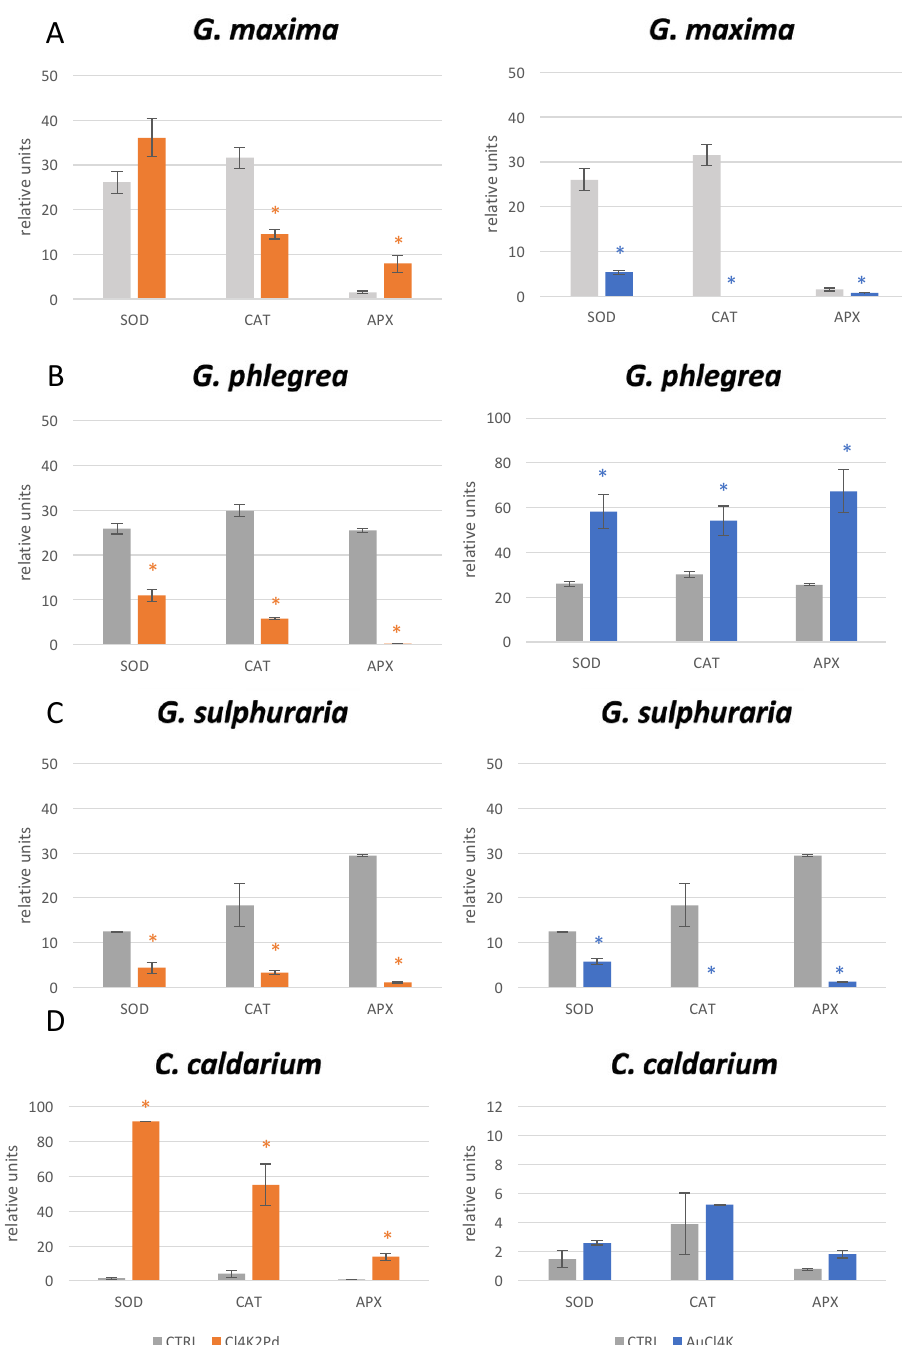
Figure 2. Evaluation of enzymatic activities after metals exposure. Relative units represent enzy- matic activity as units/g of dry weight (SOD), enzymatic activity as nmol H 2 O 2 /g of fresh weight (CAT), and enzymatic activity as µ mol ascorbate/g of fresh weight (APX). Enzymatic activities were monitored in: ( A ) G. maxima; ( B ) G. phlegrea; ( C ) G. sulphuraria; ( D ) C. caldarium , treated with 1 g/L of palladium (Cl 4 K 2 Pd, orange bars) and gold (AuCl 4 K, blue bars) after 96 h. Mean ( ± SD) was calculated from three replicates. (*) = p -value ≤ 0.05 calculated by T ‐ test.